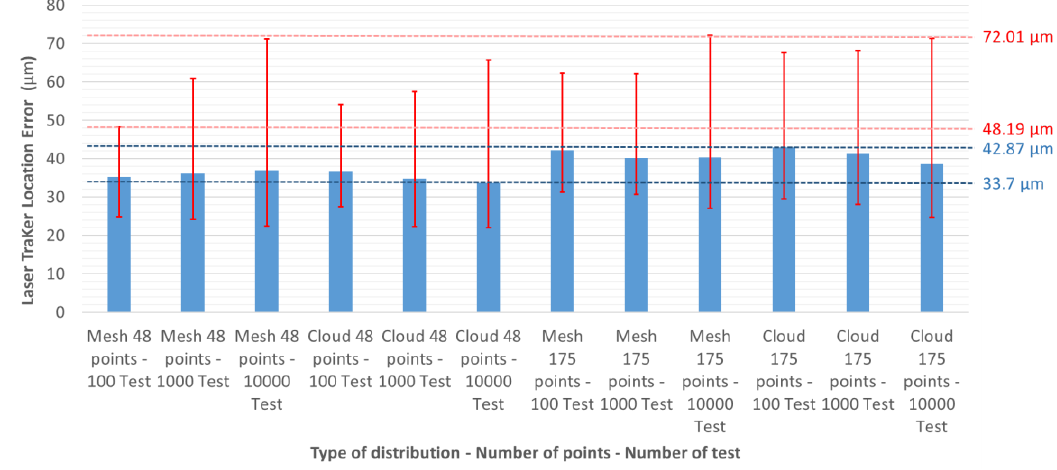
Figure 8. Error of LT location in the wide zone using one LT, depending on the type and number of tests, and the distribution and number of points.